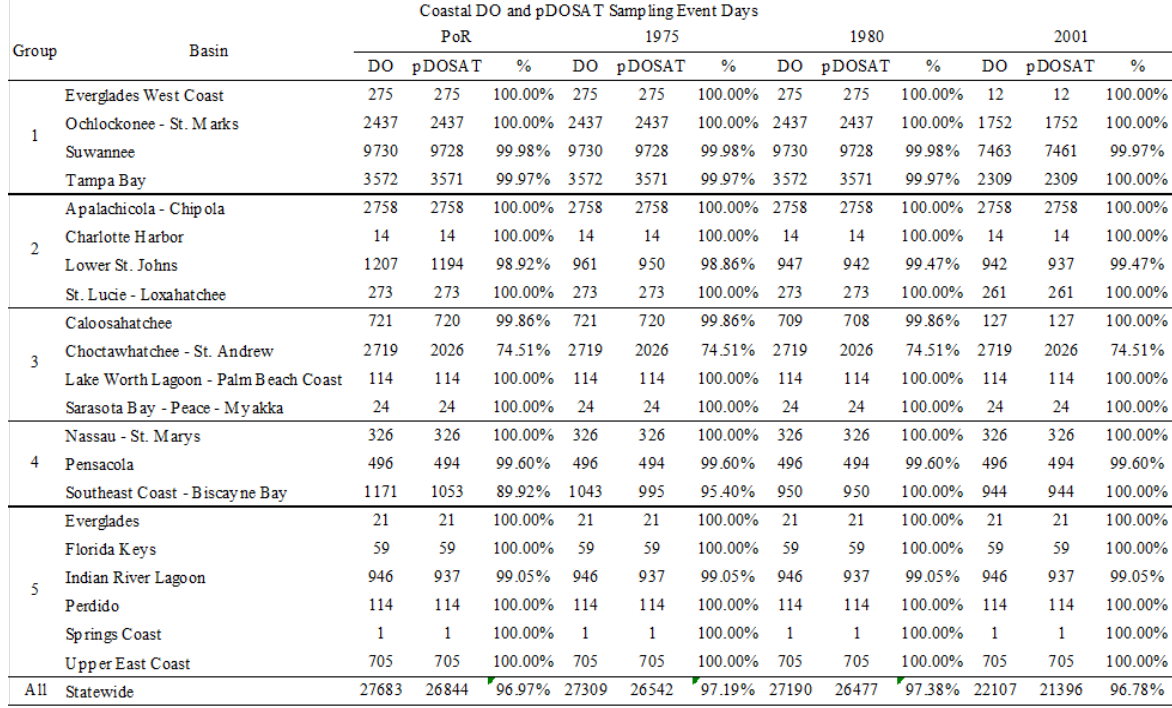
Table 1. Coastal Sampling History. pDOSAT is represented here as n and % of